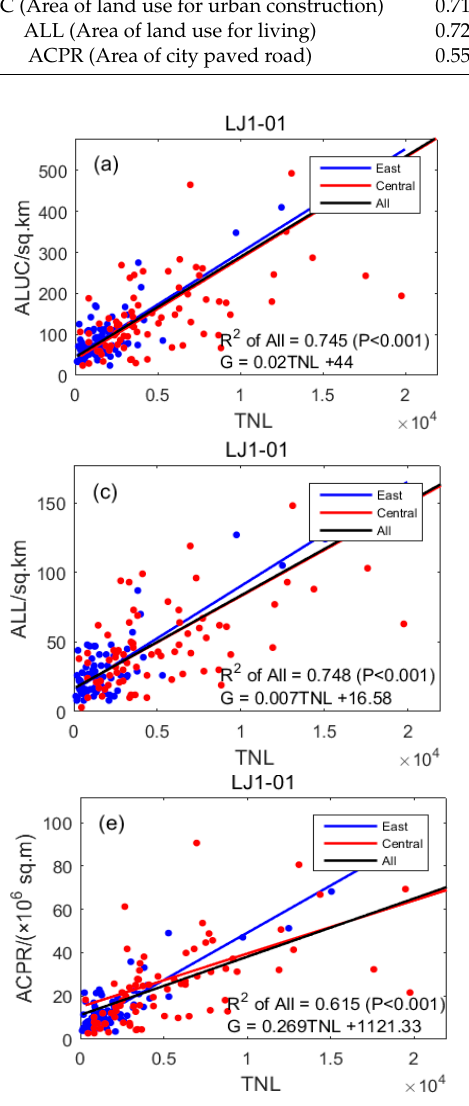
Figure 6. Scatter diagrams for the linear regression results of area of land in use and TNL: ( a ) the TNL of LJ1-01 data and ALUC; ( b ) the TNL of NPP/VIIRS data and ALUC; ( c ) the TNL of LJ1-01 data and ALL; ( d ) the TNL of NPP/VIIRS data and ALL; ( e ) the TNL of LJ1-01 data and ACPR; ( f ) the TNL of NPP/VIIRS data and